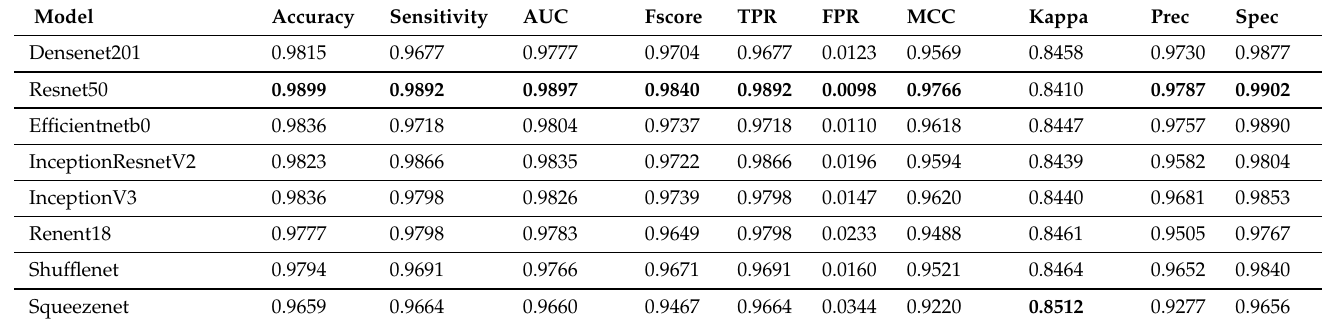
Table 10. Binary (benign vs. malignant) classifier performance: comprehensive table of metrics for features extracted from a pooled combination of all four magnifications (40 × , 100 × , 200 × , and 400 × ) of histopathological images using baseline CNN models that are classified using